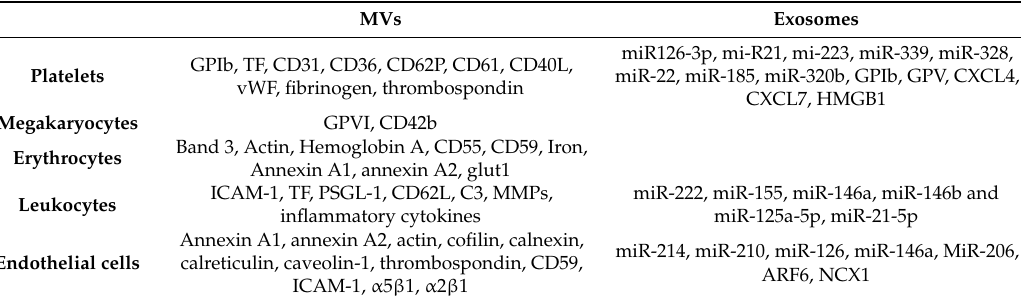
Table 2. Proteins and miRNA usually associated with MVs and exosomes. MVs